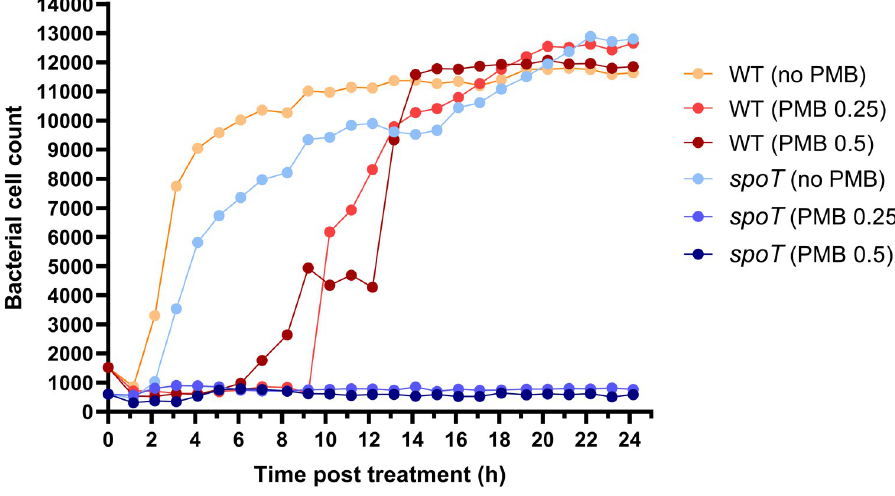
Fig 5. Time-lapse live-cell imaging reveals different growth kinetics of spoT mutant following polymyxin treatment. ImageJ was employed for imaging analysis and cell count of AB5075 wild-type (WT) and spoT mutant following polymyxin B (PMB) treatment at 0.25 or 0.5 mg/L, and no treatment (i.e., controls).